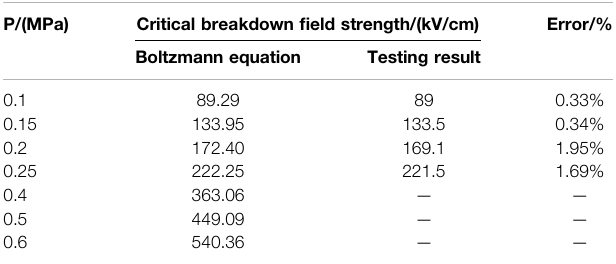
TABLE 2 | Critical breakdown fi eld at ( α - η ) /N = 0. P/(MPa)